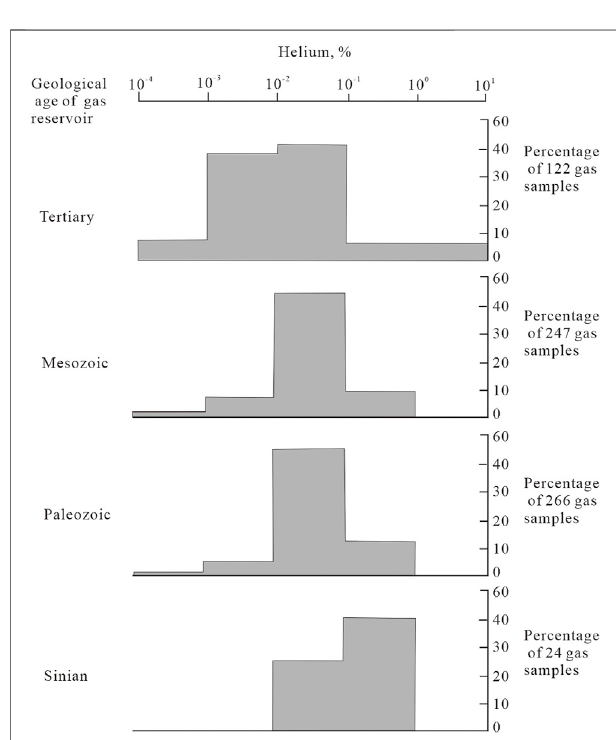
FIGURE 4 | Helium contents in gas fi elds formed in different geological area in China.